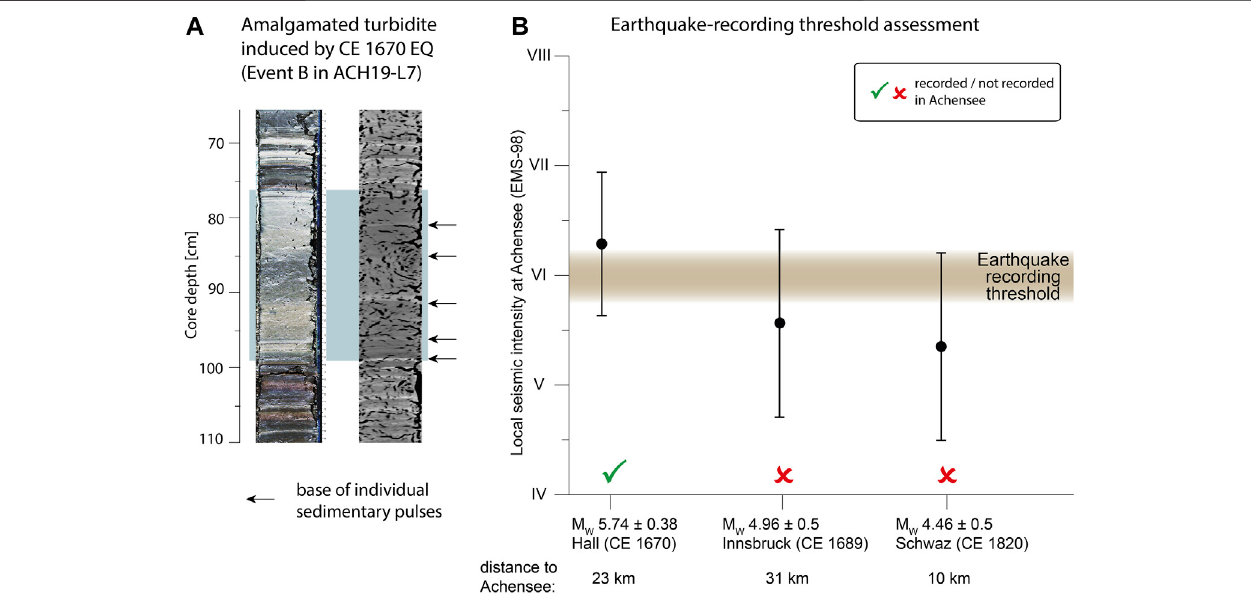
FIGURE 11 | Calibration of the earthquake imprint in Achensee. (A) Amalgamated turbidite consisting of fi ve individual sedimentary pulses (black arrows) is interpreted as the sedimentary imprint of the M W 5.7 ± 0.4 Hall earthquake (see main text for detailed description and interpretation). (B) Calculated seismic intensity at Achensee based on the magnitude range of historical earthquakes (Stucchi et al., 2013). An earthquake-recording threshold for Achenseeat local intensity I L ∼ VI results in recording the strongest historical earthquake in Hall CE 1670, but not the other two.